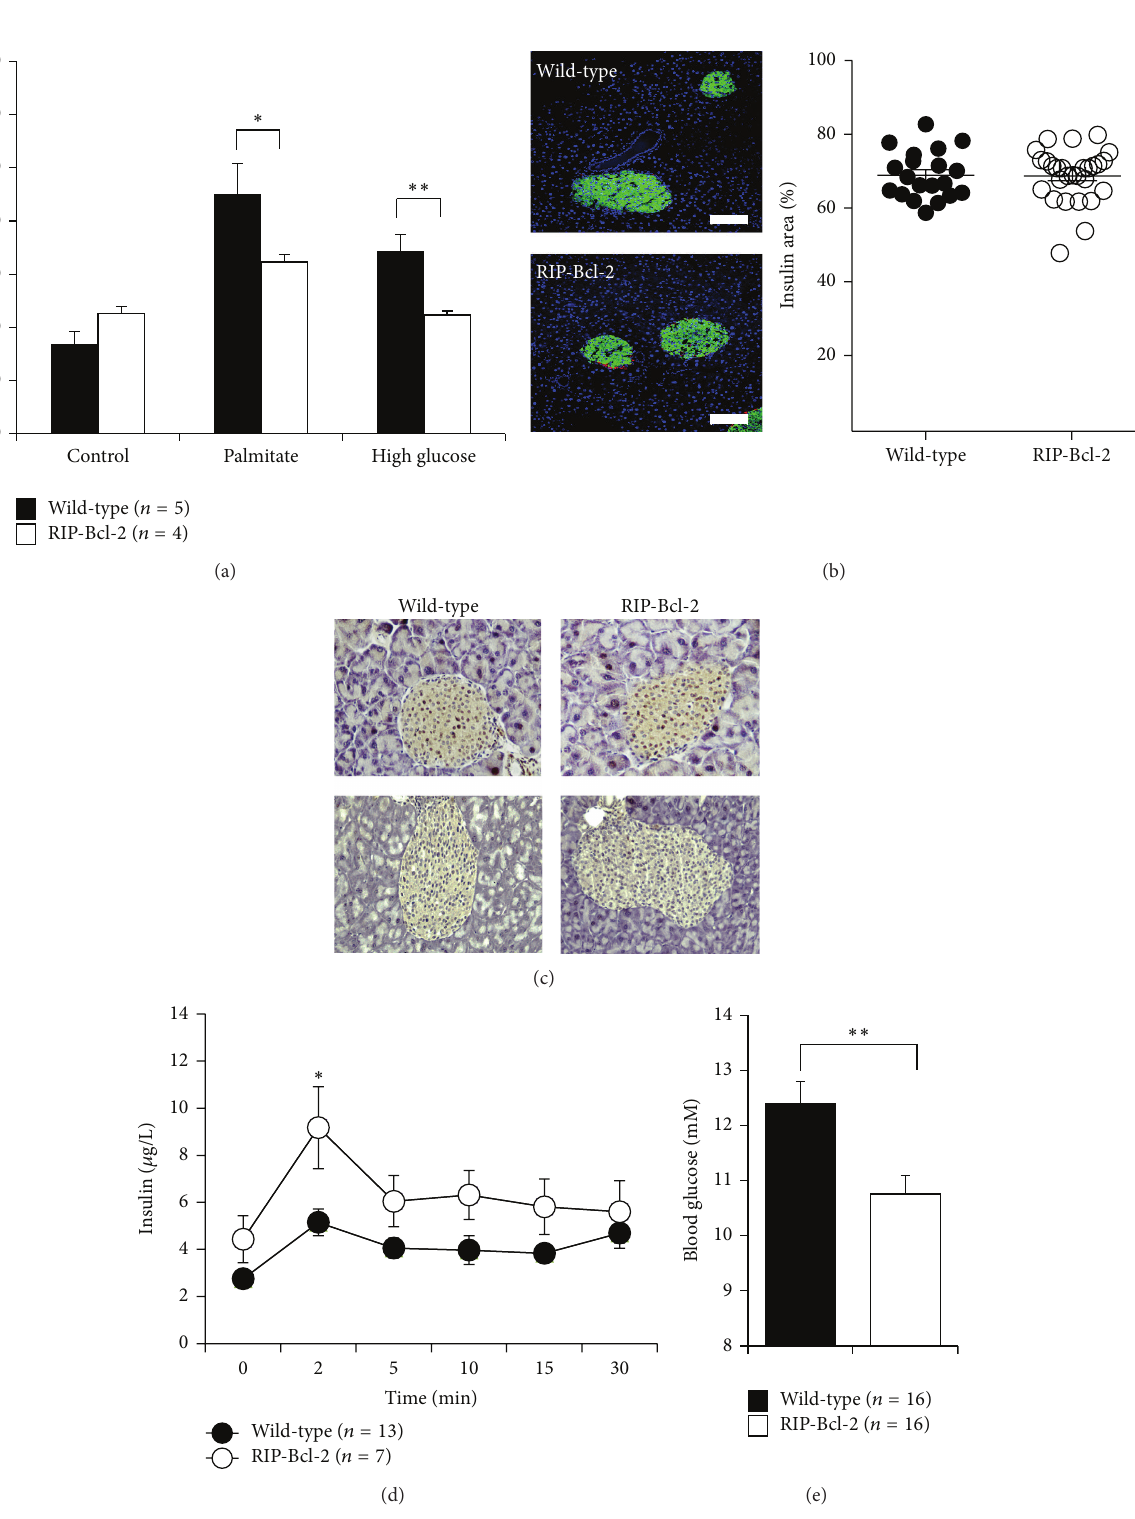
Figure 7: Overexpression of Bcl-2 improves 𝛽 -cell function during obesity. (a) Islets were obtained from wild-type C57BL/6 mice and RIP-Bcl- 2 transgenic mice. Islets were then treated with 0.5 mM palmitate or 30mM D-glucose for 5 days and subsequent levels of cell death were determined by FACS analysis. (b) Pancreas sections from wild-type and RIP-Bcl-2 mice fed on high fat for 16 weeks were stained for insulin (green), and quantification of islets from 5 mice per group is provided as percentage of islet area. BAR, 100 𝜇 m. (c) Pancreas sections from wild-type and RIP-Bcl-2 mice fed on high fat for 16 weeks were stained for ubiquitin. (d) IV-GTT results are shown in wild-type and RIP-Bcl-2 high fat fed mice. (e) Fasting (8h) blood glucose levels of wild-type and RIP-Bcl-2 mice fed on high fat for 16 weeks. ∗ 𝑃 < 0.05 ; ∗∗ 𝑃 < 0.01